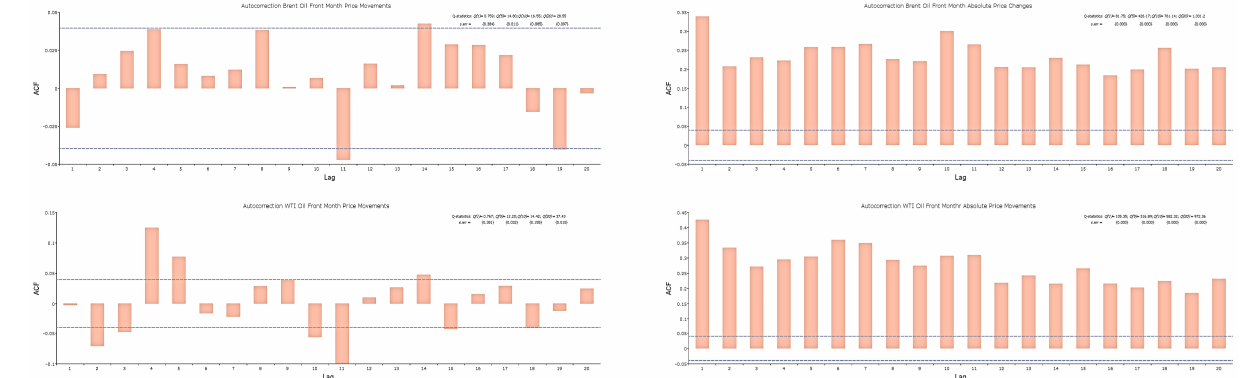
Figure 1. The ICE Brent Oil and WTI Oil Front Month contracts for the period